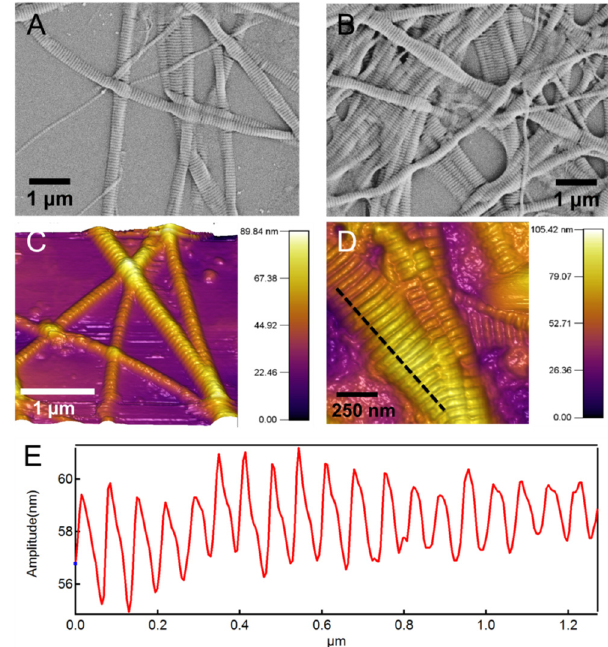
Figure 2. ( A , B ) Scanning electron microscope (SEM) morphology and ( C , D ) atomic force microscope (AFM) topography images of the native type I collagen fibrils used for synthesis of the composite hydrogel. The characteristic periodic pattern of 60–70 nm is apparent in images; ( E ) Shows a line-profile taken along the dashed line in ( D ) and shows this periodic